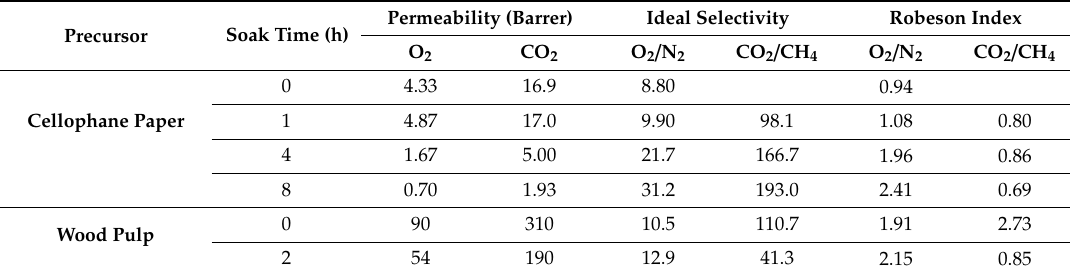
Table 4. Influence of the soak time on cellulose-based CMSM carbonized at 550 ◦ C.